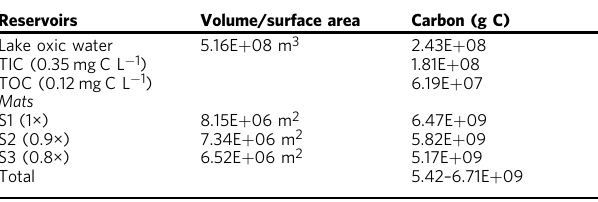
Table 1 Amount of carbon stored in the oxic water column and microbial mats of Lake Untersee,